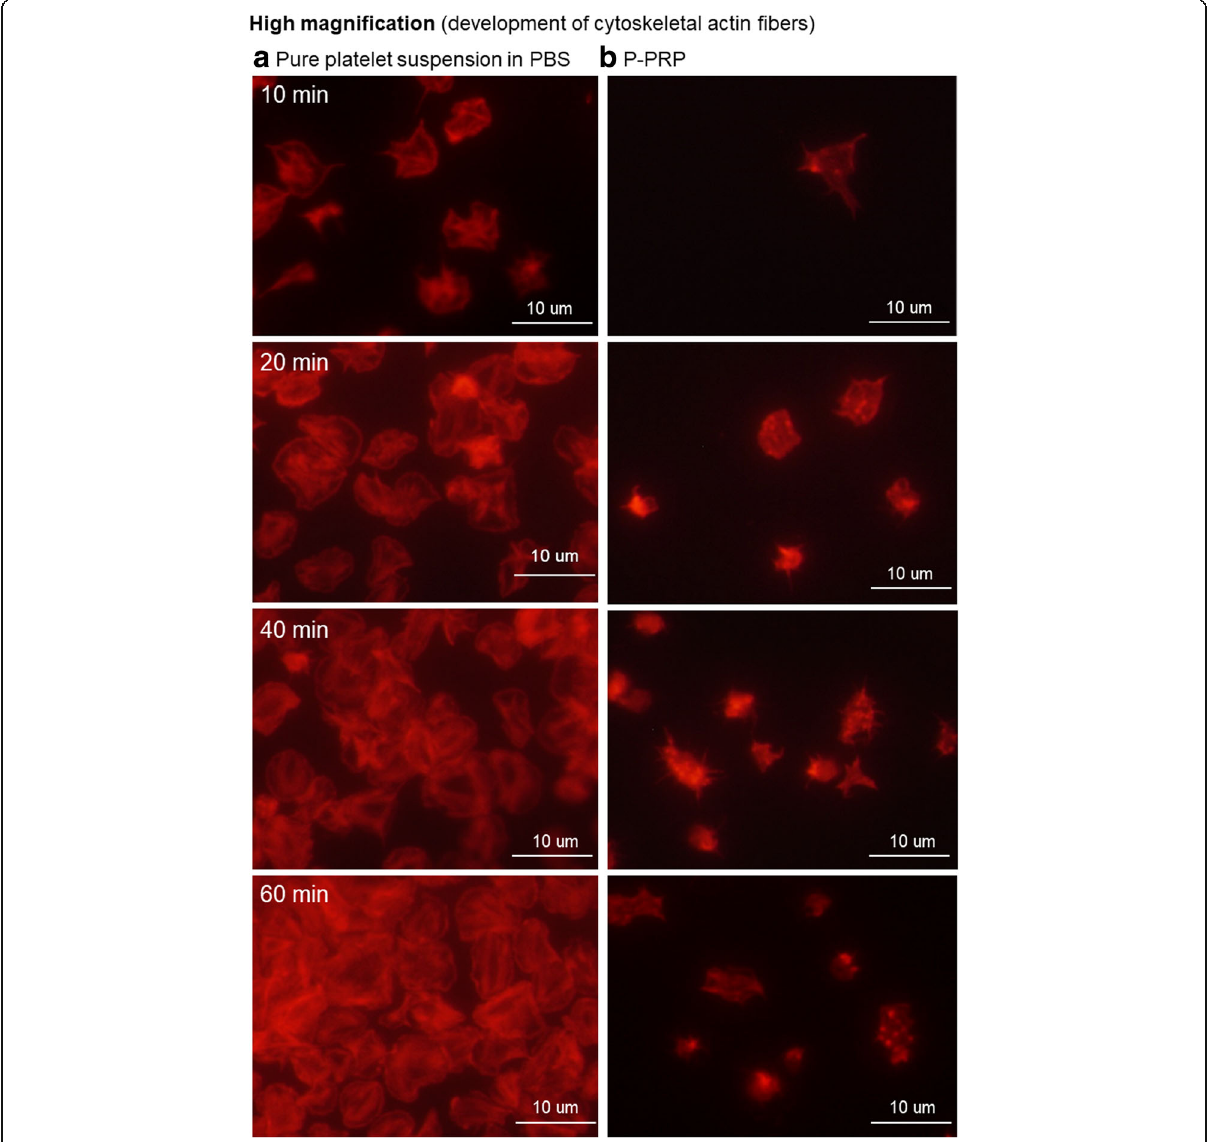
Fig. 8 Time-course of cytoskeletal actin fiber development in adhered platelets at high magnification. a Platelets suspended in PBS and b P-PRP. PBS phosphate-buffered saline, P - PRP pure platelet-rich